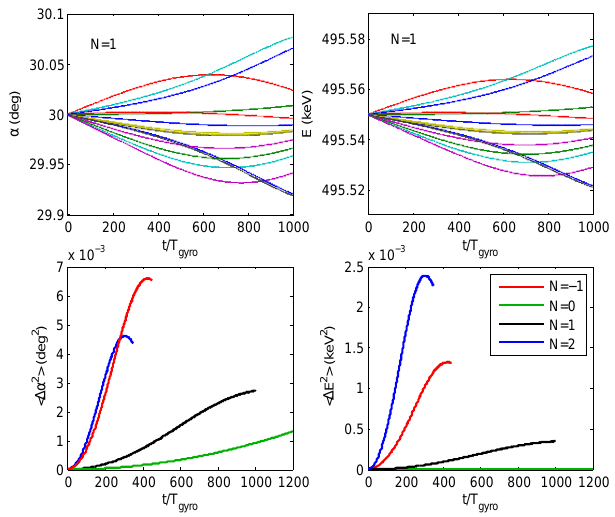
Figure 5. Results of resonant diffusion of an ensemble of electrons having the same initial pitch angle 30 ◦ and different energies to resonate with artificial waves at 1kHz for four resonance harmon- ics. Top: changes of pitch angle (left) and kinetic energy (right) of 15 randomly selected electrons for the N = 1 resonance. Bottom: changes of 1α 2 (left) and 1 E 2 (right) averaged over all 200 elec- trons for four resonance harmonics, N = − 1, 0, 1, and 2. Note that initial electron energy varies with resonance harmonic to satisfy the resonance condition and consequently T gyro also varies with reso- nance